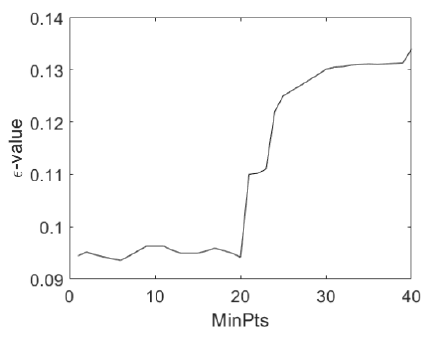
Figure 3. 𝜀 as a function of 𝑀𝑖𝑛𝑃𝑡𝑠 for 0.1𝑏(𝑡) level noise. Figure 3. ε as a function of MinPts for 0.1 b ( t ) level